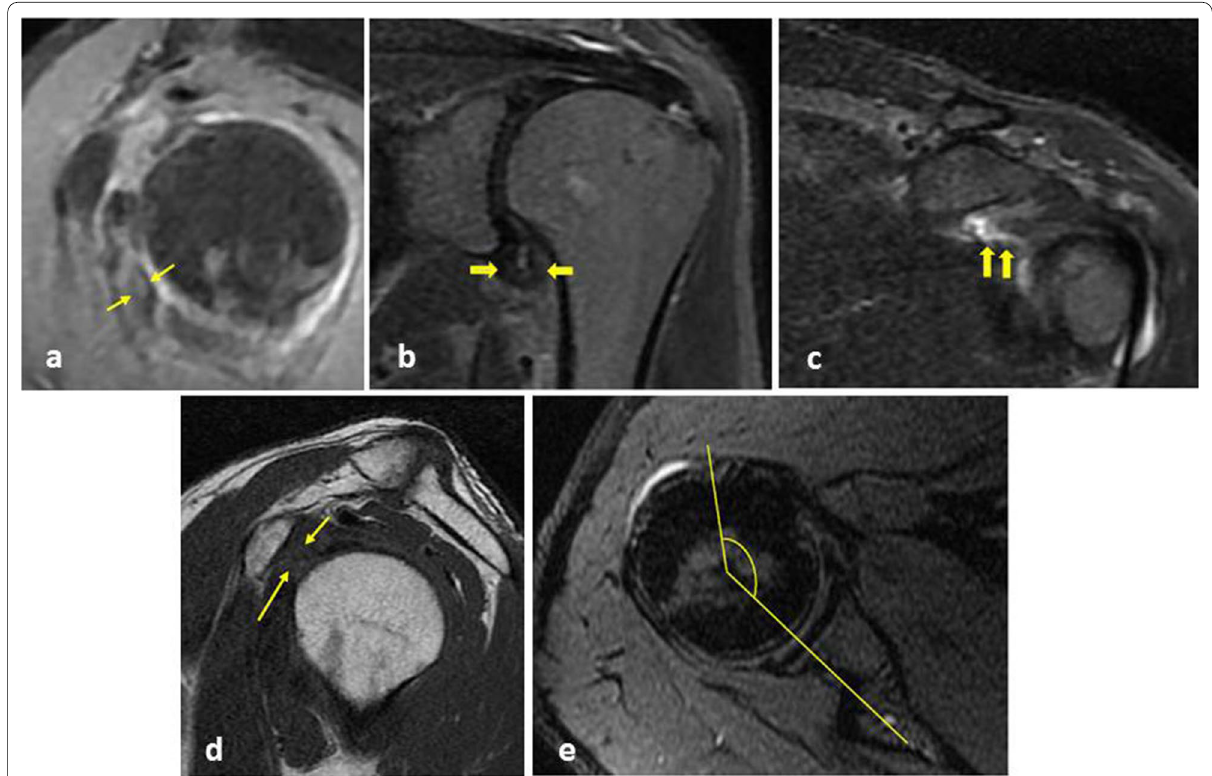
Fig. 4 Example illustrating the qualitative MR measurements. A 48-year-old woman with clinically suspected adhesive capsulitis (shoulder pain and limitation of movement). a Oblique 3D sagittal PD fat suppressed weighted images showing increased anterior capsule signal and thickness (yellow arrows). b Oblique coronal fat-sat T2-weighted image demonstrating axillary capsule thickening and abnormal increased signal intensity. There is increased thickness at the glenoid and humeral parts of the axillary joint capsule with high T2 signal intensity (thick yellow arrows). c Oblique coronal fat sat T2-weighted image at the level of coracoid process illustrating high signal intensity at the subcoracoid fat triangle (thick yellow arrows). d Oblique sagittal T1-weighted image demonstrating an obliterated subcoracoid fat triangle (thin yellow arrows). e Axial PD fat suppressed weighted image at the level of center of humeral head showing the angle of external